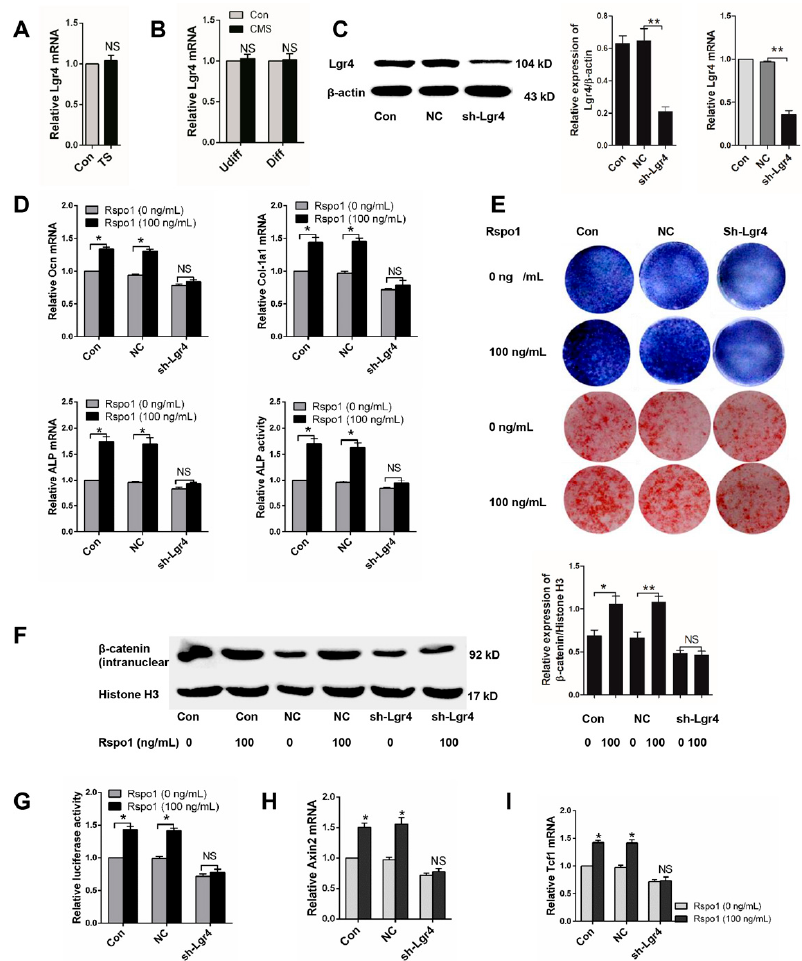
Figure 6. Lgr4 was essential for Rspo1 to promote osteogenic differentiation and Wnt/ β -catenin signaling activity in BMSCs. ( A ) qRT-PCR analysis of Lgr4 in distal femurs of Con and TS mice ( n = 6) and ( B ) in BMSCs treated with 5% CMS; ( C ) Western blot and qRT- PCR analysis of Lgr4 after lentivirus sh-Lgr4 infection; ( D ) qRT-PCR analysis of osteogenic differentiation markers ( Ocn , Col-1a1 , ALP ) and ALP activities assay of lentivirus infected BMSCs after three days of osteogenic induction with or without Rspo1 (100 ng/mL); ( E ) representative images of ALP staining (Day 10) and Alizarin red staining (Day 18) of each group cells; ( F ) Western blot analysis of the intranuclear level of β -catenin and ( G ) Topflash dual-luciferase activity assay of BMSCs after 24 h of osteogenic differentiation; ( H ) qRT-PCR analysis of the Wnt target genes Axin2 and ( I ) Tcf1. All data were confirmed by three repeated tests and are presented as the mean ± SD, * p < 0.05, ** p < 0.01. All p -values are based on Student’s t -test. NC: negative control; sh-Lgr4: short hairpin RNA-Lgr4